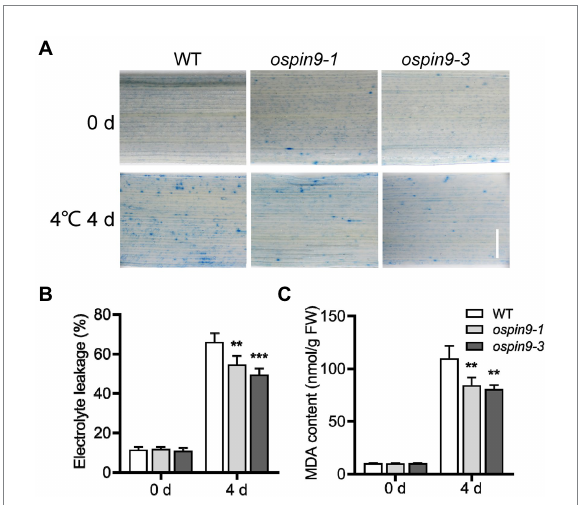
FIGURE 5 Mutation of OsPIN9 altered cell damage, cell membrane stability and lipid peroxidation in rice seedling leaves. (A) Trypan blue staining; Bar = 1 mm. (B) Electrolyte leakage; (C) Malondialdehyde contents. The samples were taken randomly from the leaves of at least six plants of each independent (WT, ospin9-1 , and ospin9-3 ) line after different time points of chilling stress. Values are means ± standard deviation (SD; n = 6). Data were analyzed by ANOVA and Tukey’s tests at p < 0.05 significant